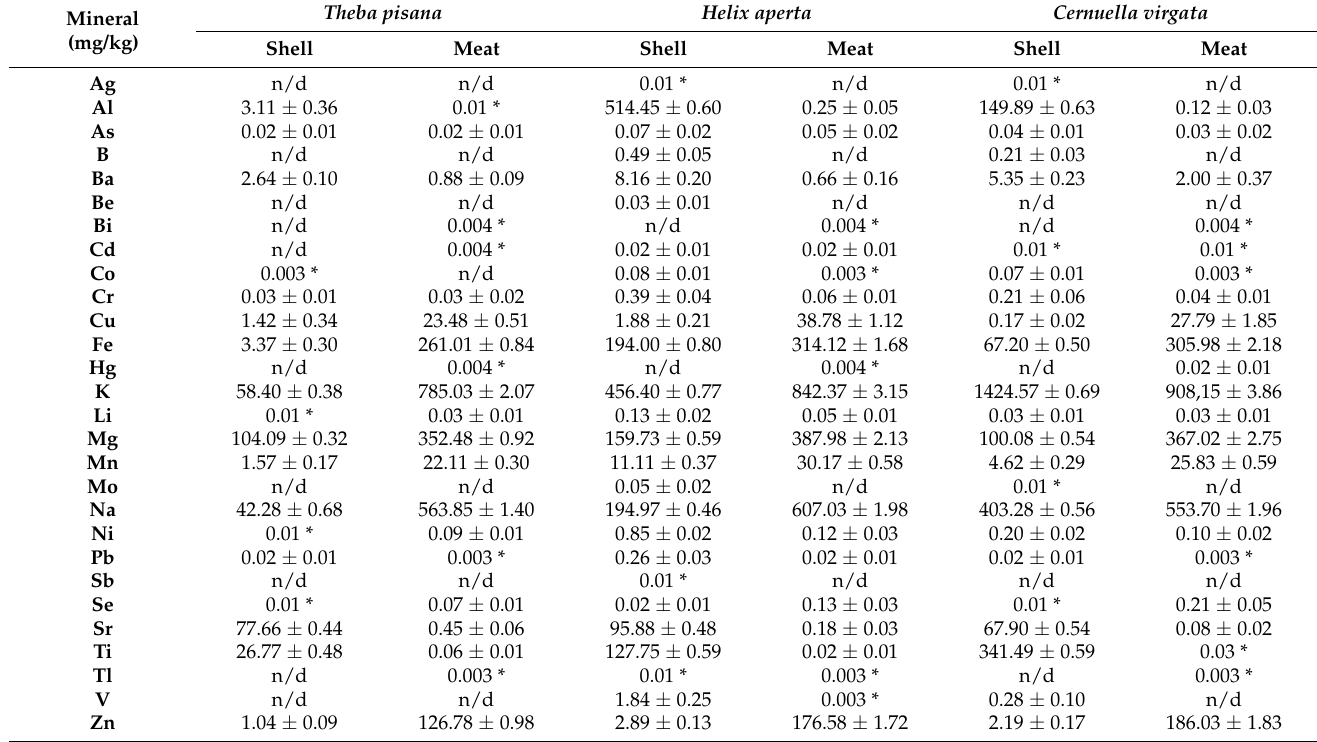
Table 5. Average mineral contents in different species of gastropods, expressed as mg/kg. Theba Mineral (mg/kg)